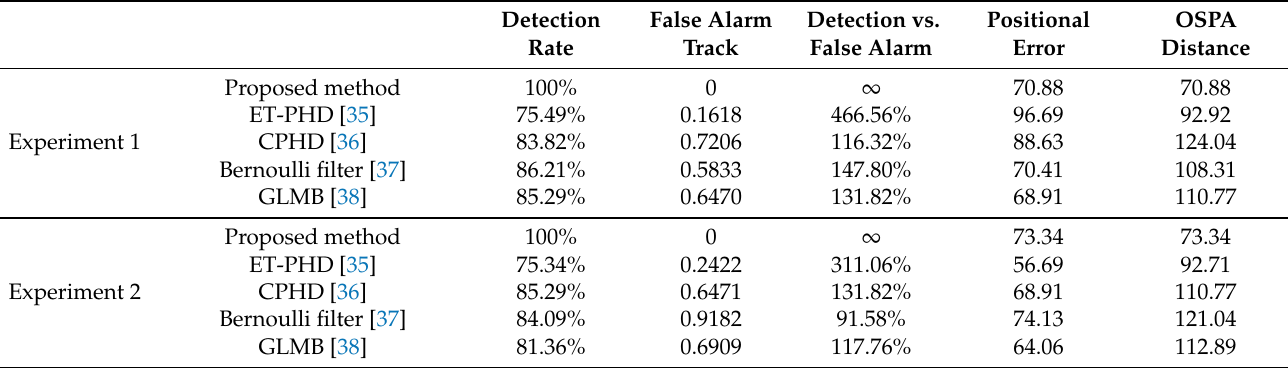
Figure 7. ( a ) The measurements in of scenario 1 among 1 to 200 scans. ( b ) The tracklets obtained in 20 time windows. ( c ) The smoothed track and the ground truth. ( d ) The target position obtained by the ET-PHD filter [35]. Table 5. Result of two real